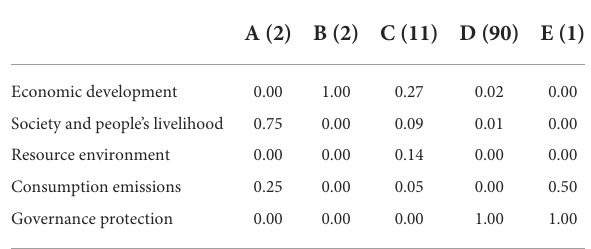
TABLE 5 Top-level clustering